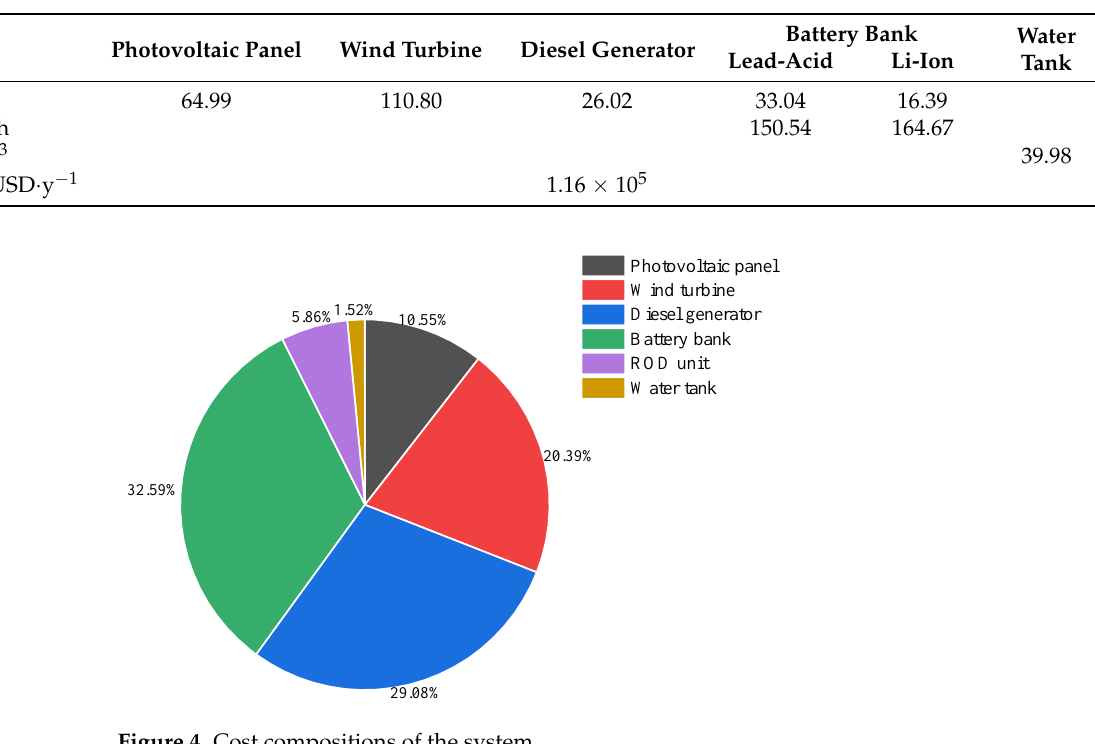
Table 2. Optimal results of the system.